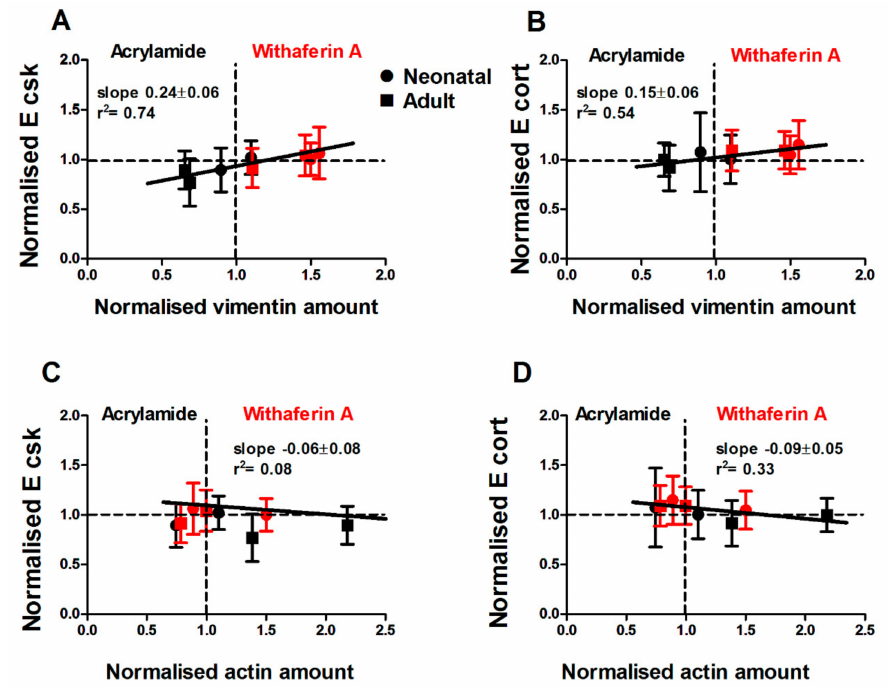
Figure 6. Changes in vimentin but not actin amount modulate E CSK and E cort . Corresponding plots of ( A ) cytoskeleton and ( B ) cortical stifness show a significant correlation to vimentin amount. Cell treatments with withaferin A and acrylamide show a correlation between E and amount of vimentin. Changes in actin amount in treated cells do not e ff ect cell ( C ) cytoskeletal and ( D ) cortical Young’s modulus. Plots are presented using acrylamide 4 and 6 mM, and withaferin A 2.5 and 5 µ M concentrations. The data of drug treatment and significant di ff erences are presented in Supplementary Figure